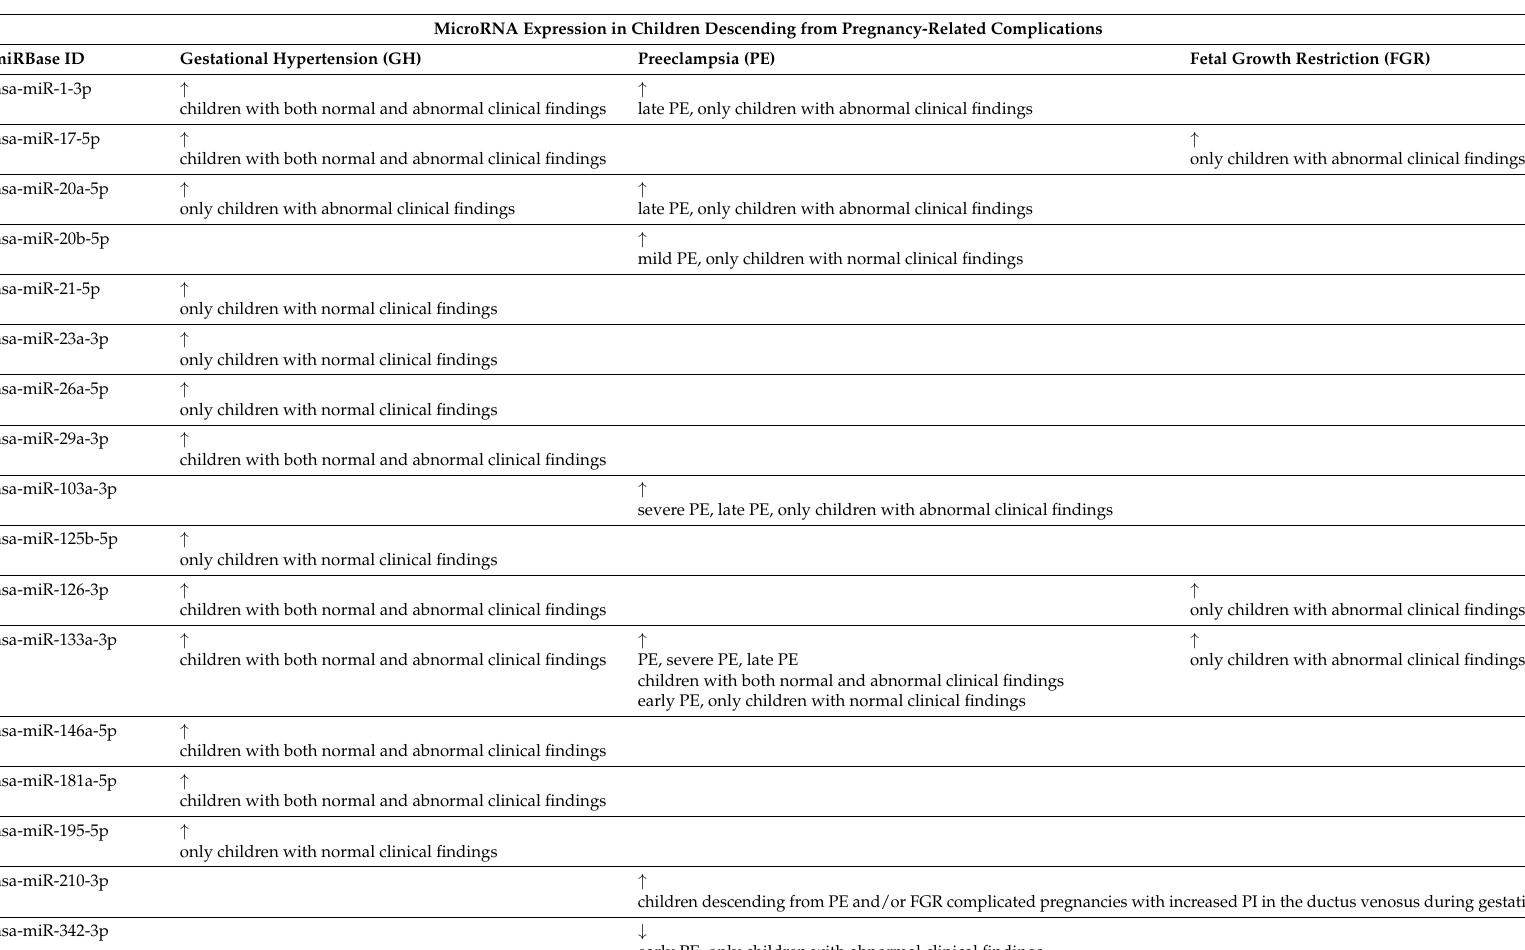
Table 1. Aberrant expression profile of microRNAs in children descending from pregnancy-related